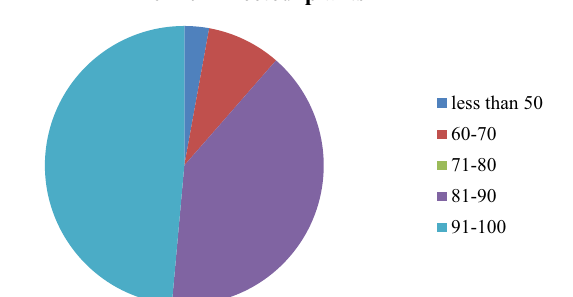
Fig. 1 Percentage bacterial isolates causing mortality in Meloidogyne incognita juveniles